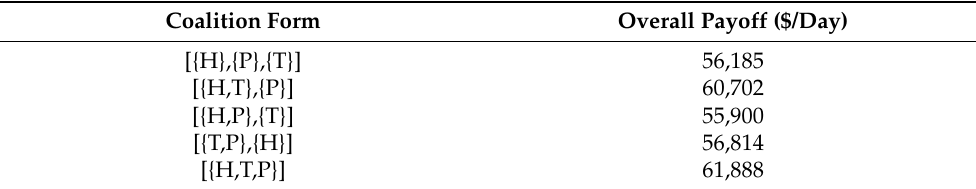
Table 3. The overall payoff of each coalition.